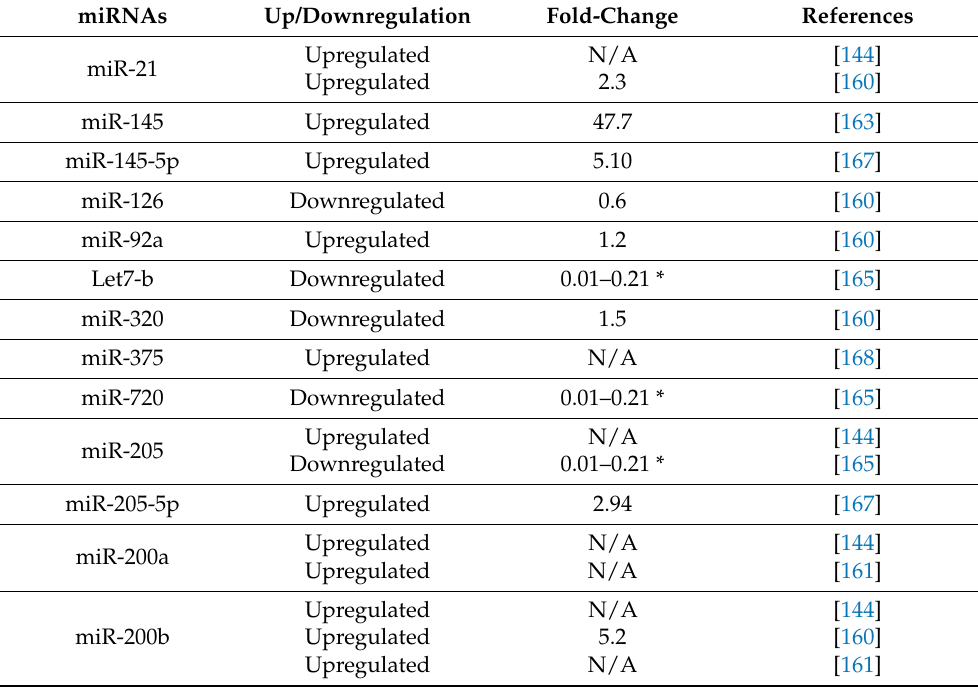
Table 6. EV-associated biomarkers investigated for ovarian cancer